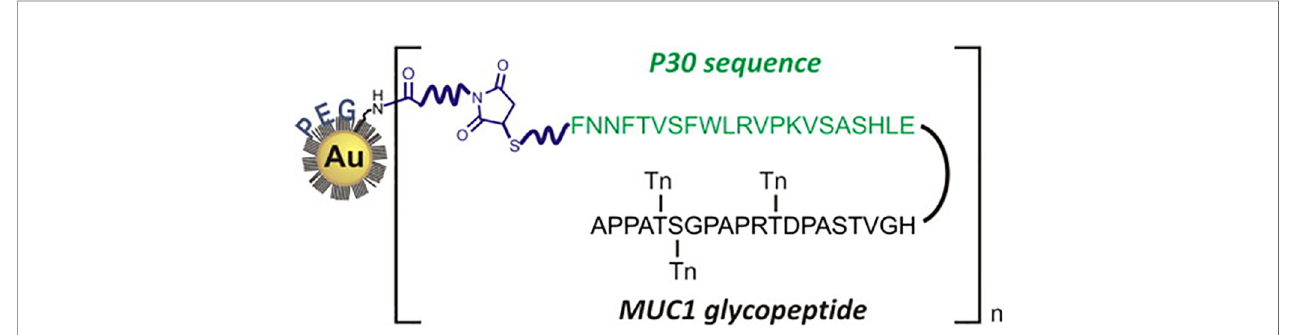
FIGURE 4 | Design of Westerlind, et al., of PEGylated AuNPs with covalently-linked TACA glycopeptide coupled to the Tetanus Toxoid T-cell motif P30 (reprinted from reference